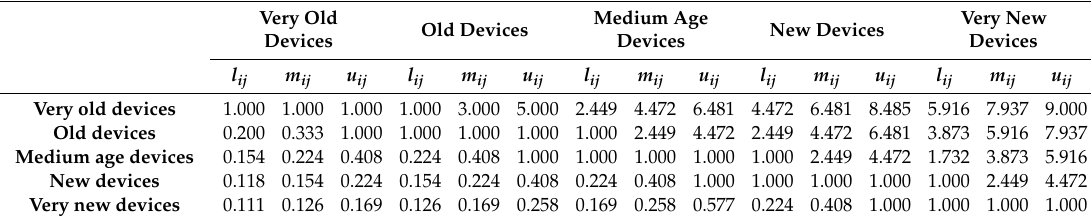
Table 10. Pairwise comparison matrix resulting from the geometric mean between the decisions of the decision makers between the scale levels of the criterion Years since start-up.